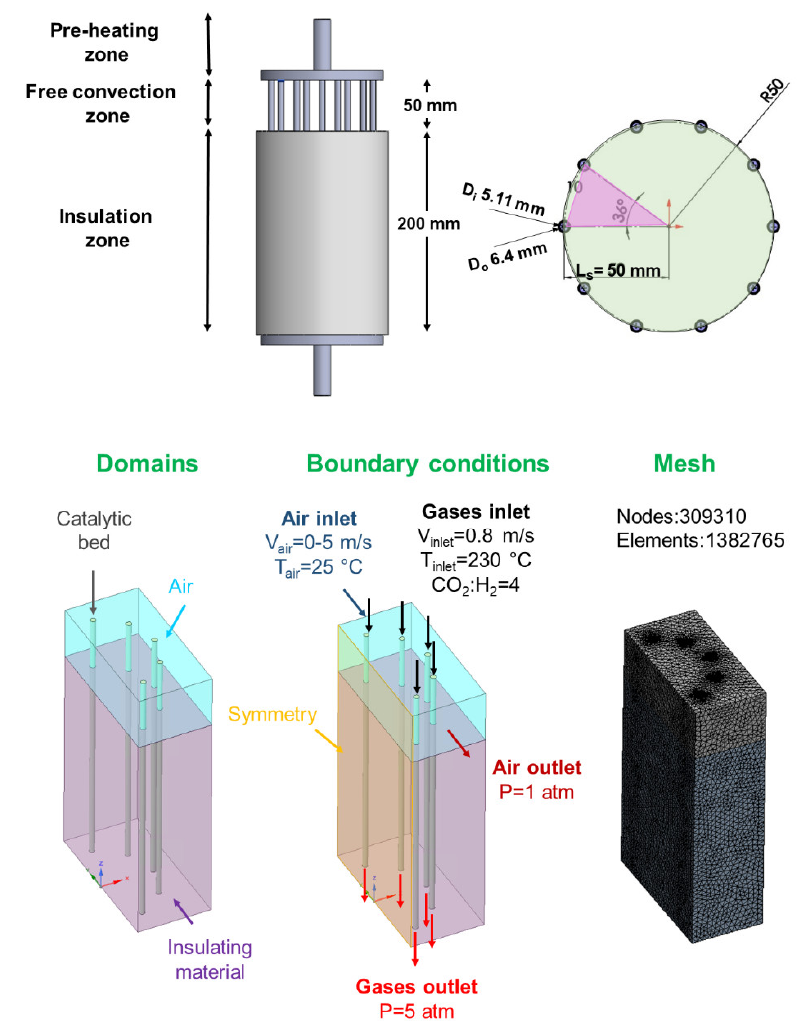
Figure 1. Geometry, boundary conditions, and mesh of the multi-tubular fixed-bed reactor design. Specifications for the reactor design: number of reactive channels = 10; geometry configuration = circular-shaped distribution; reactive channel length separation = 50 mm; free-convection zone = 50 mm; insulation zone = 200 mm.